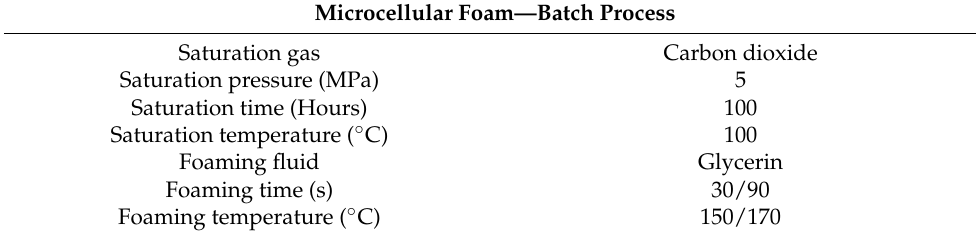
Table 2. Experimental conditions.